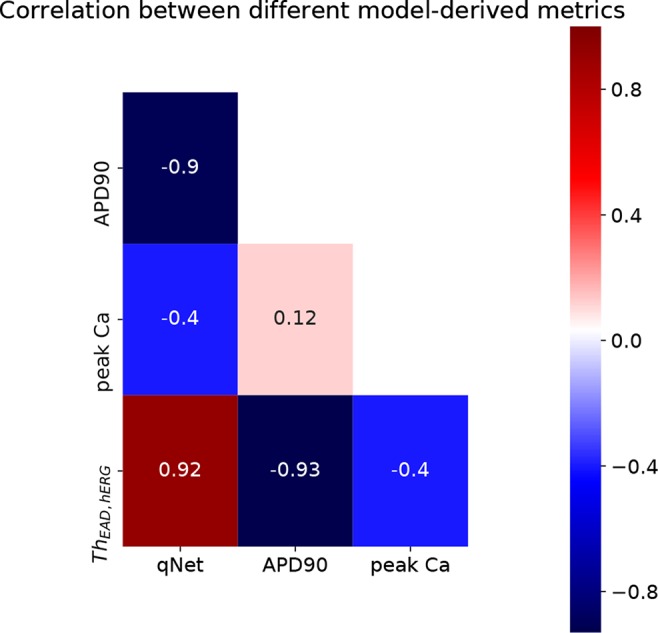
Heatmap of correlation between qNet, APD90, peakCa, and ThEAD,hERG metrics.